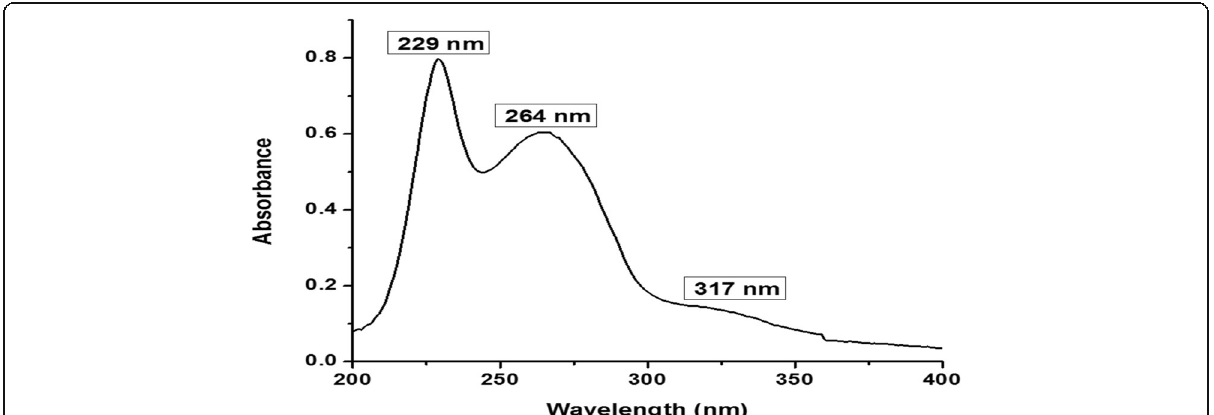
Fig. 6 UV absorption spectrum of killer toxins for Wickerhamomyces anomalus (WK) toxin (10 mg/ml H2O) using UV-visible quartz cell with path length of 1 cm at 298 K